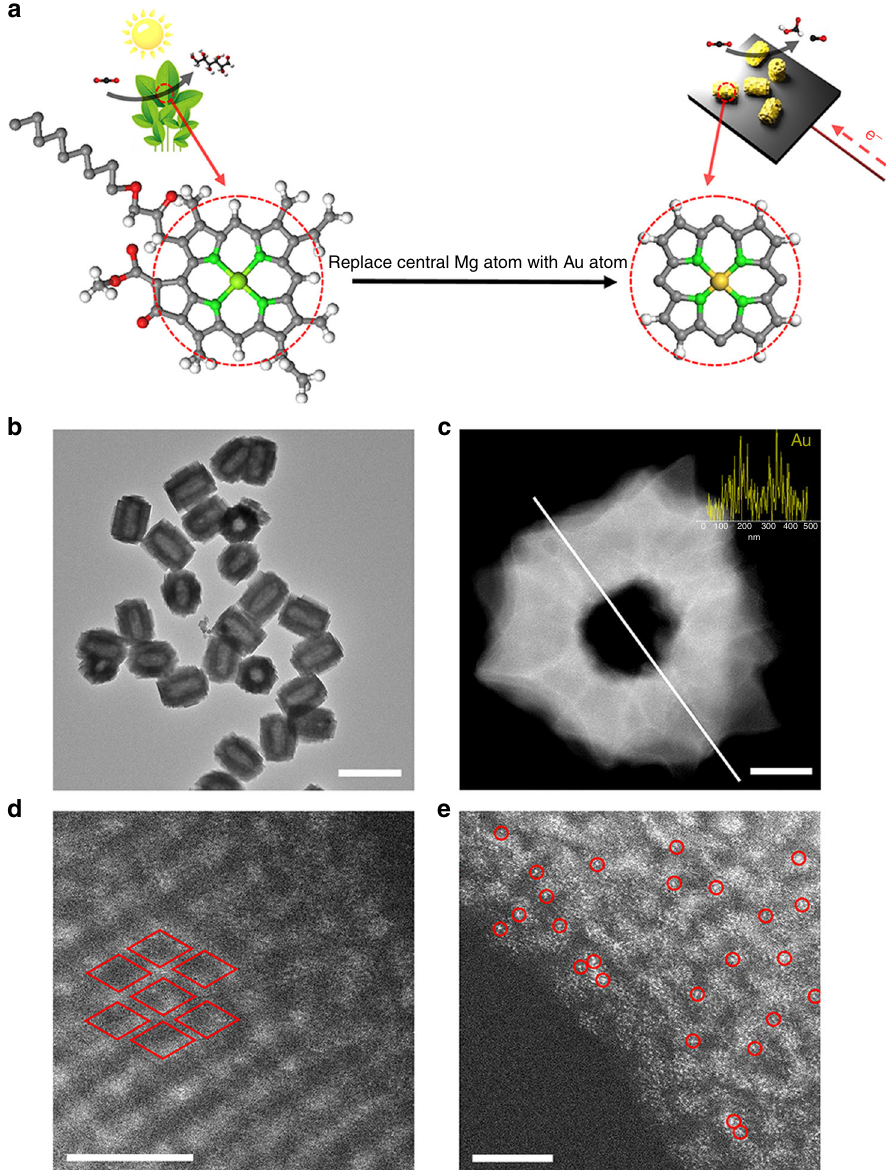
Fig. 1 Preparation and nanostructure characterization of HNTM-Au-SA. a Schematic illustration of photosynthesis and photoelectrochemical reduction of CO 2 on chlorophyll and HNTM-Au-SA, respectively. b TEM image. c STEM image (inset is line-scanning spectrum for Au element). d HRTEM image. Each rhombus represents a porphyrin unit. e HAADF STEM image. Single Au atoms are highlighted in red circles. Scale bar: b is 1 μ m, c is 50 nm, d , e is 5